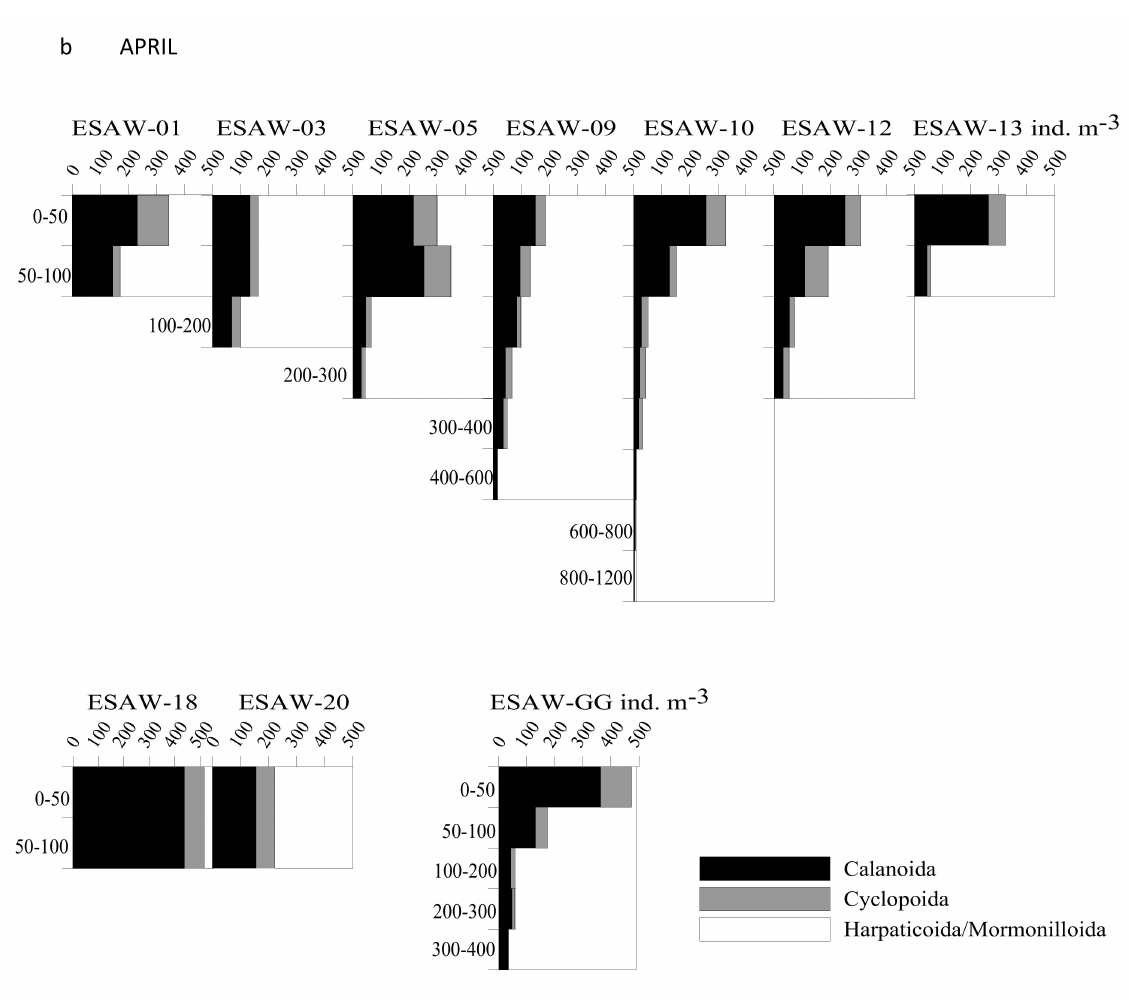
Figure 3. Spatial distribution of the total copepod densities in December 2015 ( a ) and April 2016 ( b